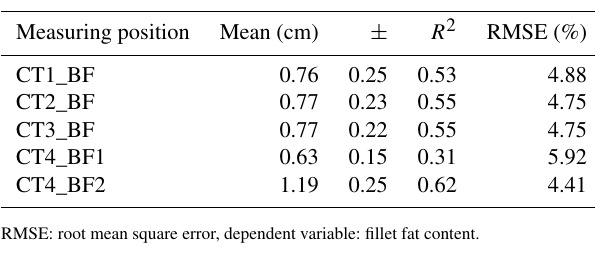
Table 2. Mean and standard deviation ( ± ) of the back-fat thick- ness over four CT scan positions as well as the coefficients of de- termination ( R 2 ) for back-fat thickness measured on a single CT image and fillet fat content measured by chemical analysis ( n = 33, p < 0 . 001).